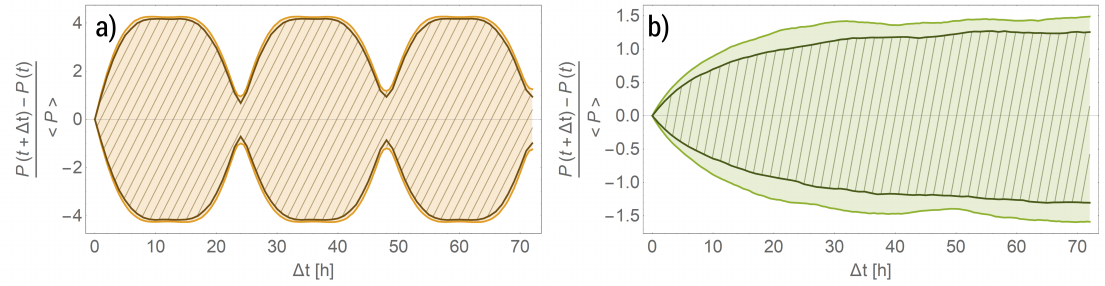
Figure 3. Indicator for intermittency of ( a ) PV (yellow) and ( b ) wind (green), in France (colored area) and France + Germany (hatched